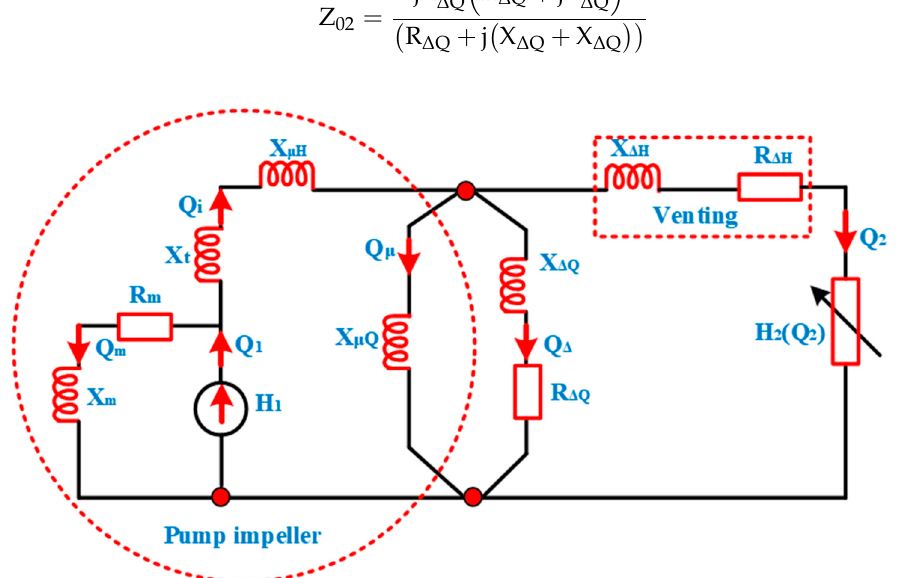
Figure 1. Equivalent circuit of centrifugal pump.